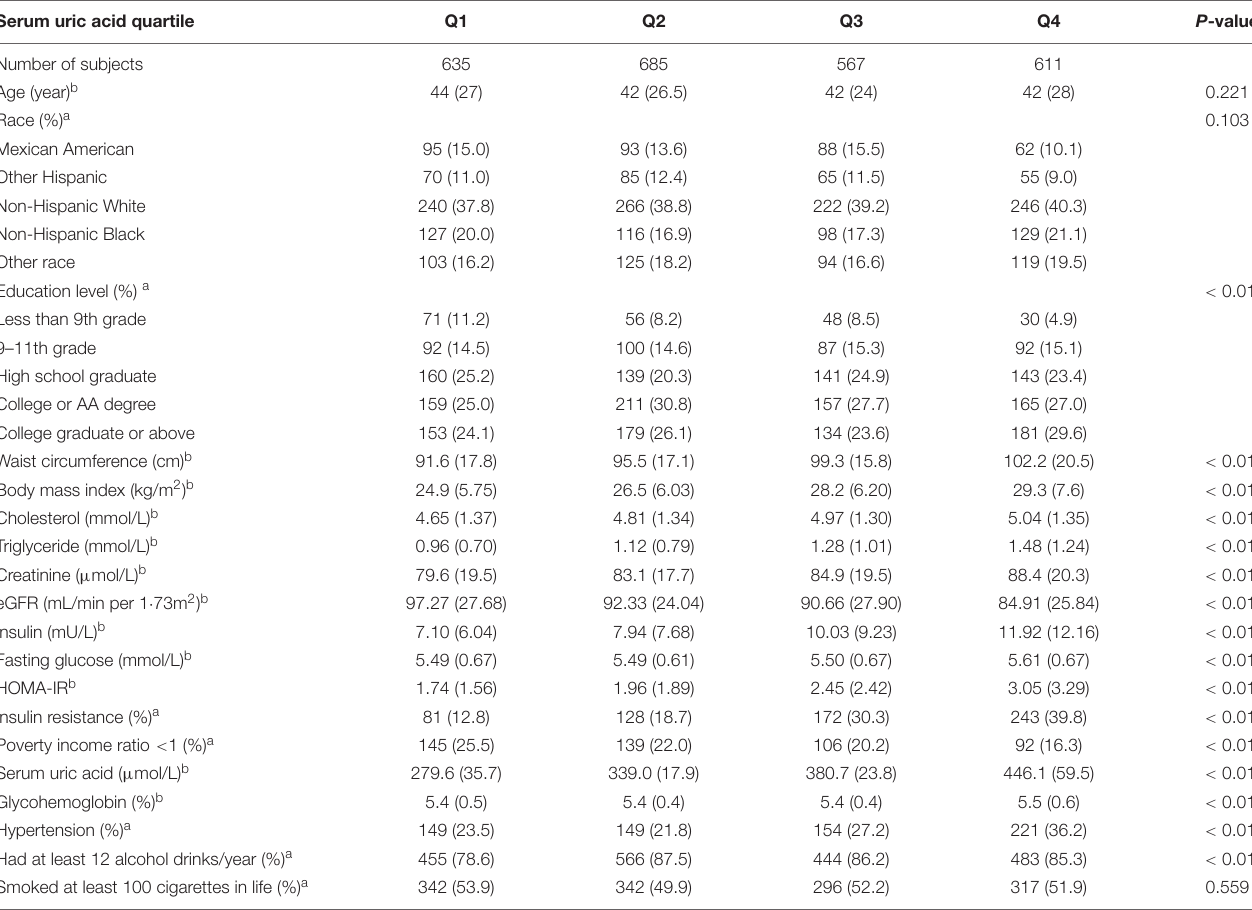
TABLE 1 | Clinical characteristics of the study population disaggregated by quartiles of serum uric acid level. Serum uric acid